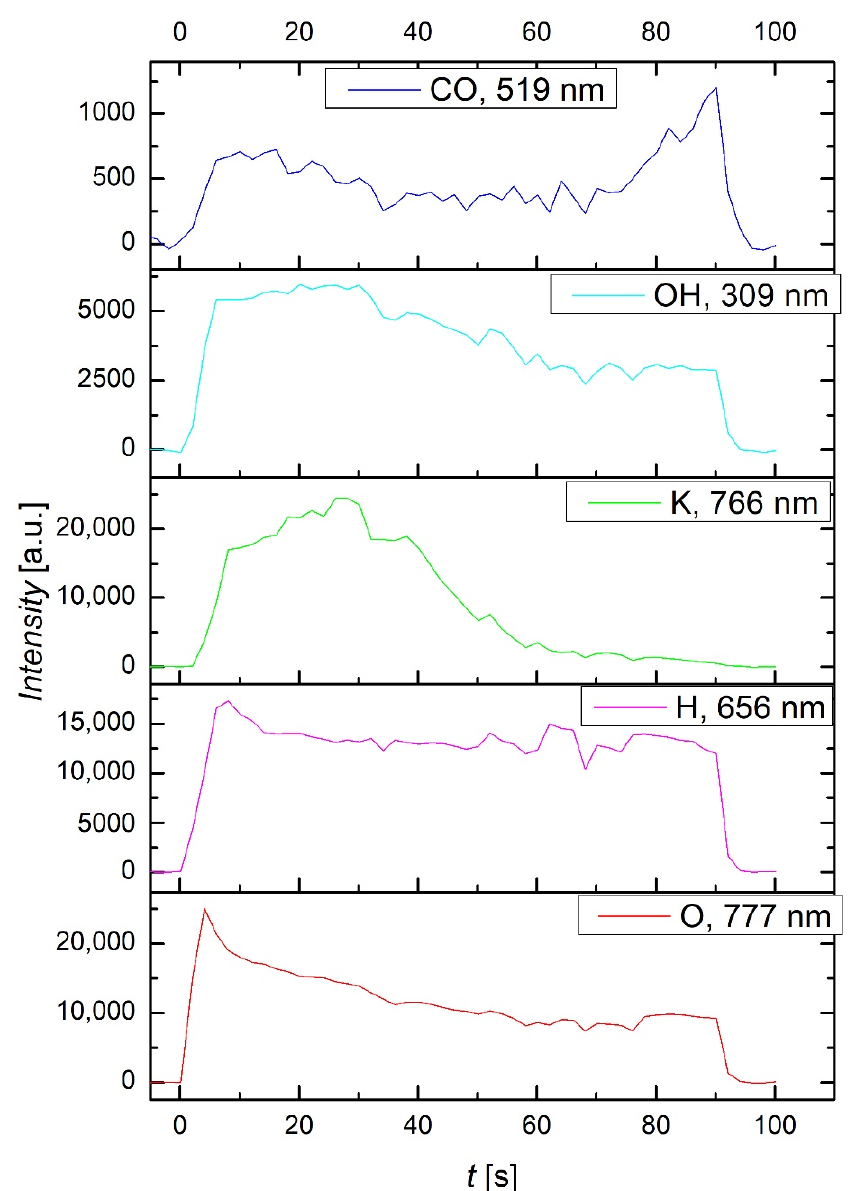
Figure 12. The intensity of some optical features versus plasma treatment time.